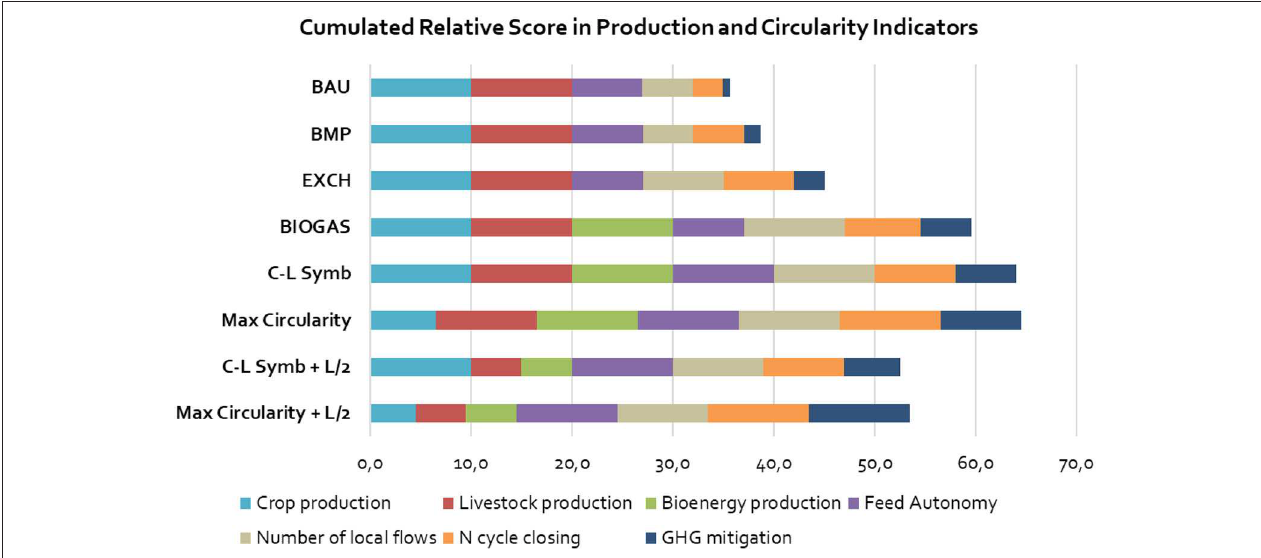
FIGURE 8 | Cumulated relative score in food production and circularity indicators of the scenarios. Scenarios names are presented in Figure 3 and Table 2 .